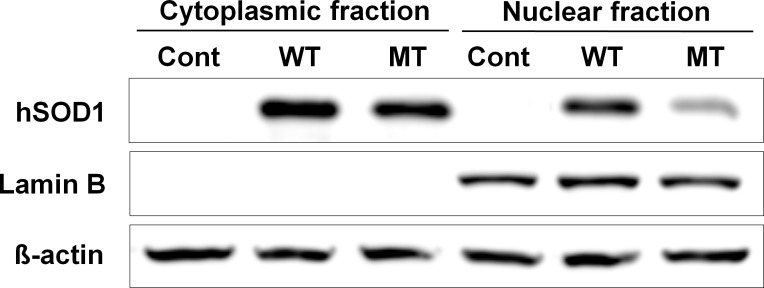
Western blots of marker proteins from the nuclear and cytoplasmic fractions of the NSC34 cells expressing the wild-type (WT) or mutant human SOD1 (G93A).Lamin B, a nuclear protein marker, was exclusively expressed in the nuclear fraction. Actin was used as a loading control to confirm equal protein loading. Cont, Control; MT, mutant cells; WT, wild-type cells.